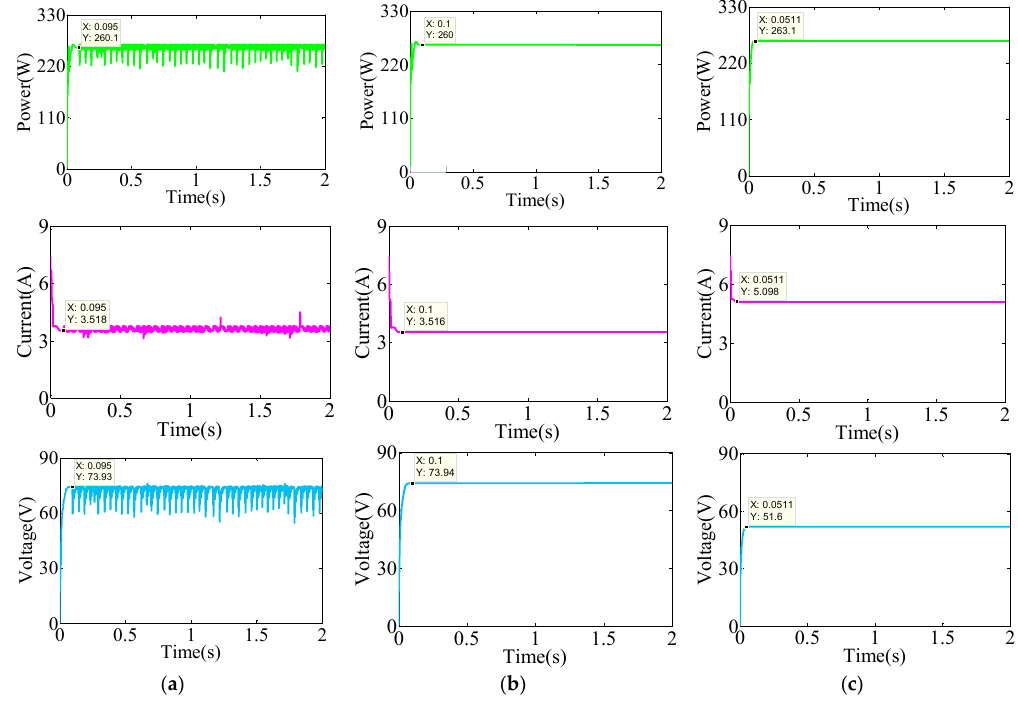
Figure 9. Power, current and voltage tracking curves of P&O, FPA and MFPA for strong shading ( a ) P&O; ( b ) FPA; ( c ) MFPA. Table 2. Performance evaluation of P&O, FPA and MFPA method for simulation results.